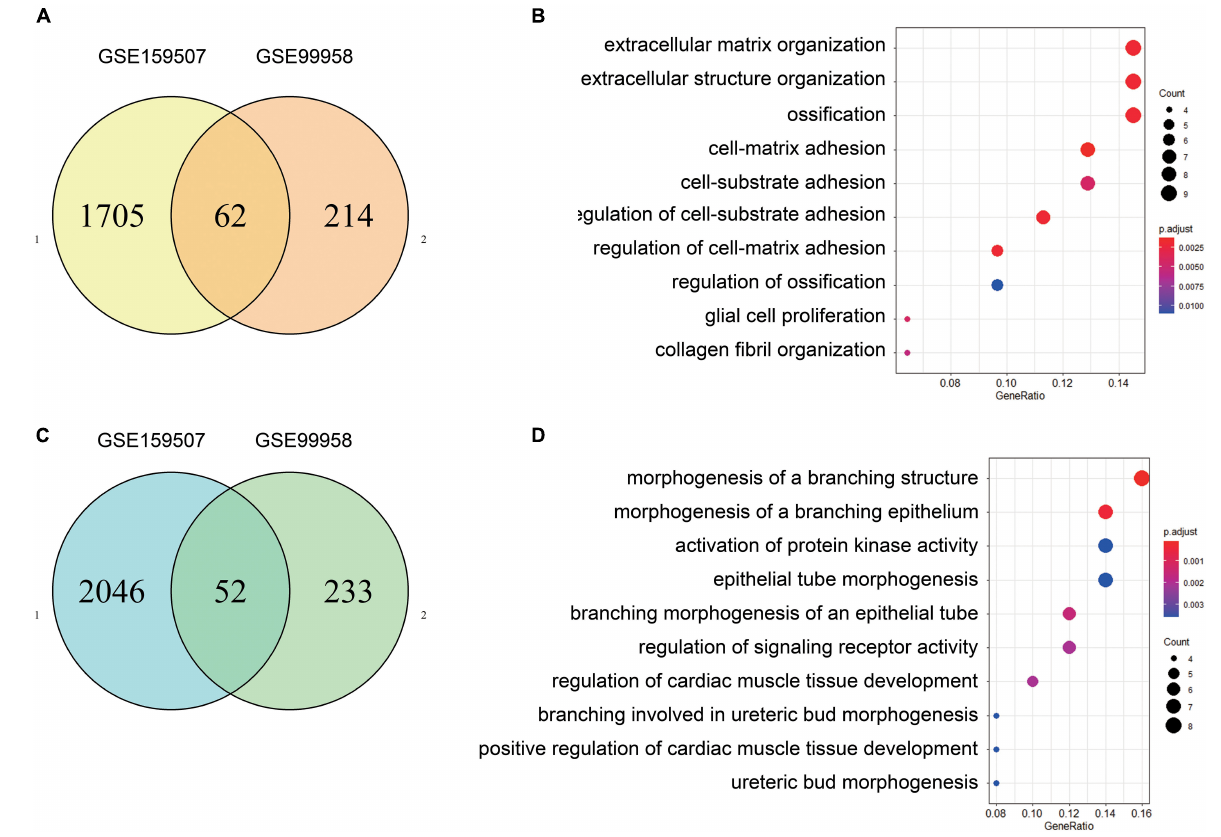
Frontiers in Genetics |